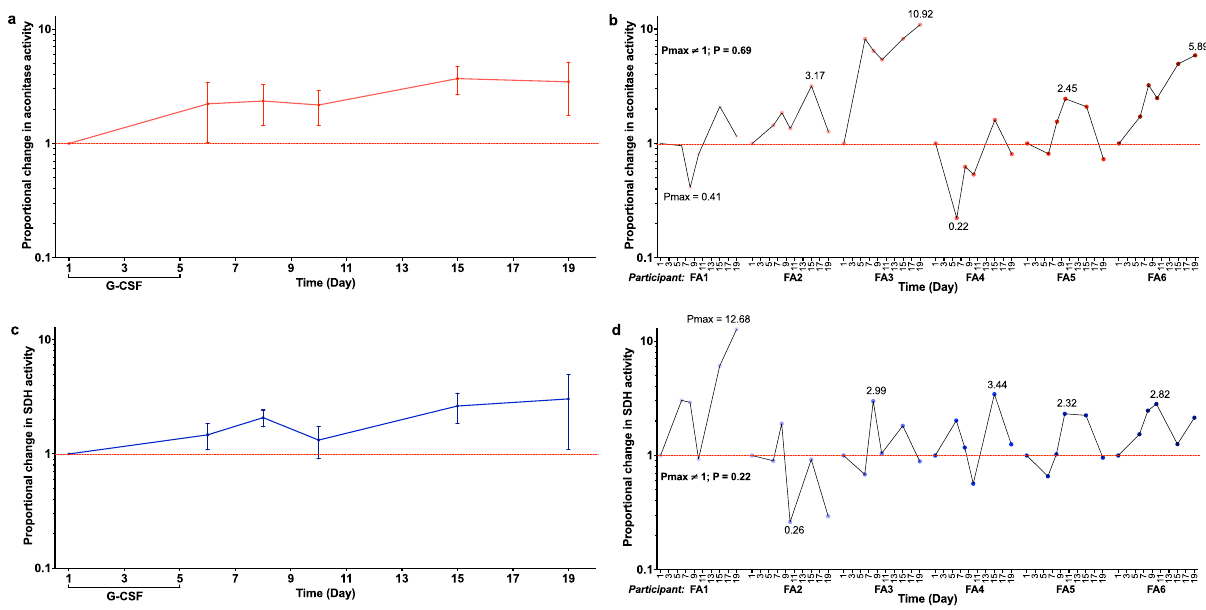
Fig. 4 The activities of aconitase and SDH in peripheral MNCs post G-CSF administration. The proportional changes in ( a ) aconitase and ( c ) SDH activity in PB MNCs, relative to baseline (day 1) levels, over the 19-day study period (graphs depict mean ± standard error; n = 6 biologically independent samples); data from individual participants are shown in graphs ( b ; aconitase) and ( d ; SDH). The sign test (two-sided) was used to compare P max values to a theoretical median of 1.0. Source data are provided as a Source Data fi